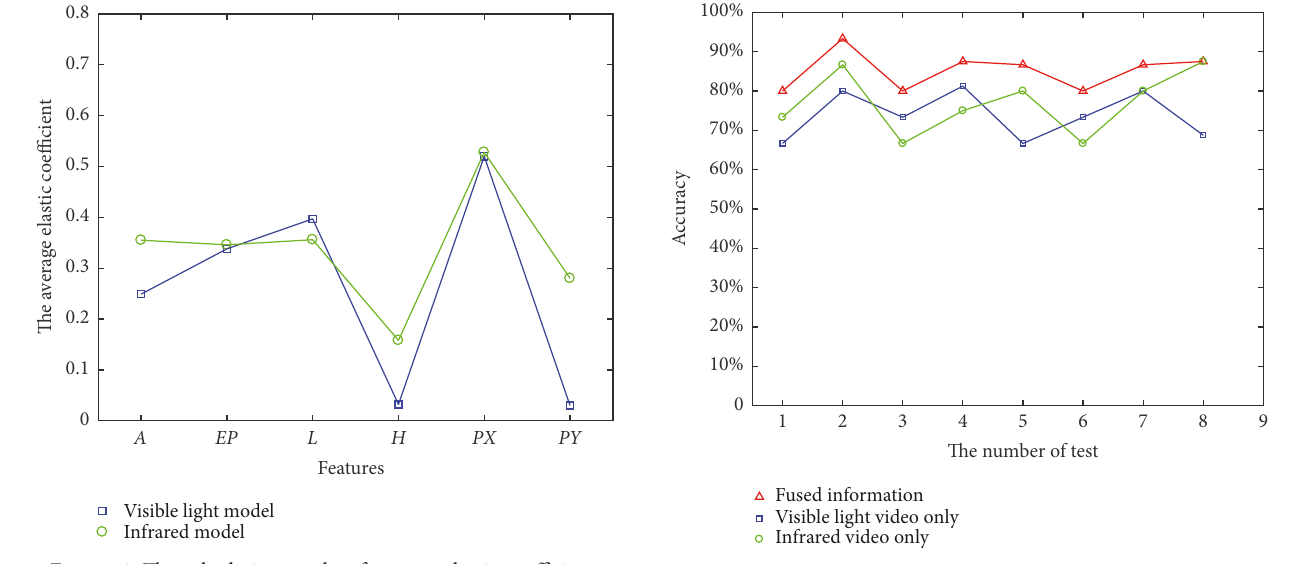
Figure 9: The calculation results of average elastic coefficient.